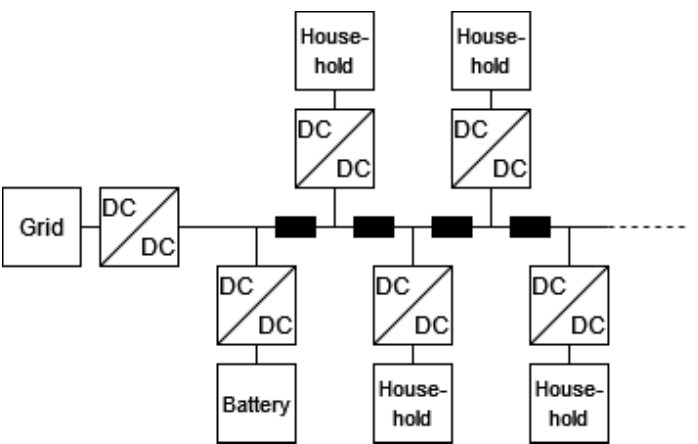
Figure 5. Schematic of the microgrid. Converters are marked by the label “DC/DC”, while the labels “Grid”, “Battery”, and “Household” represent simple models of the given elements. Black boxes represent a pi-model line, as described in Section 4.1.